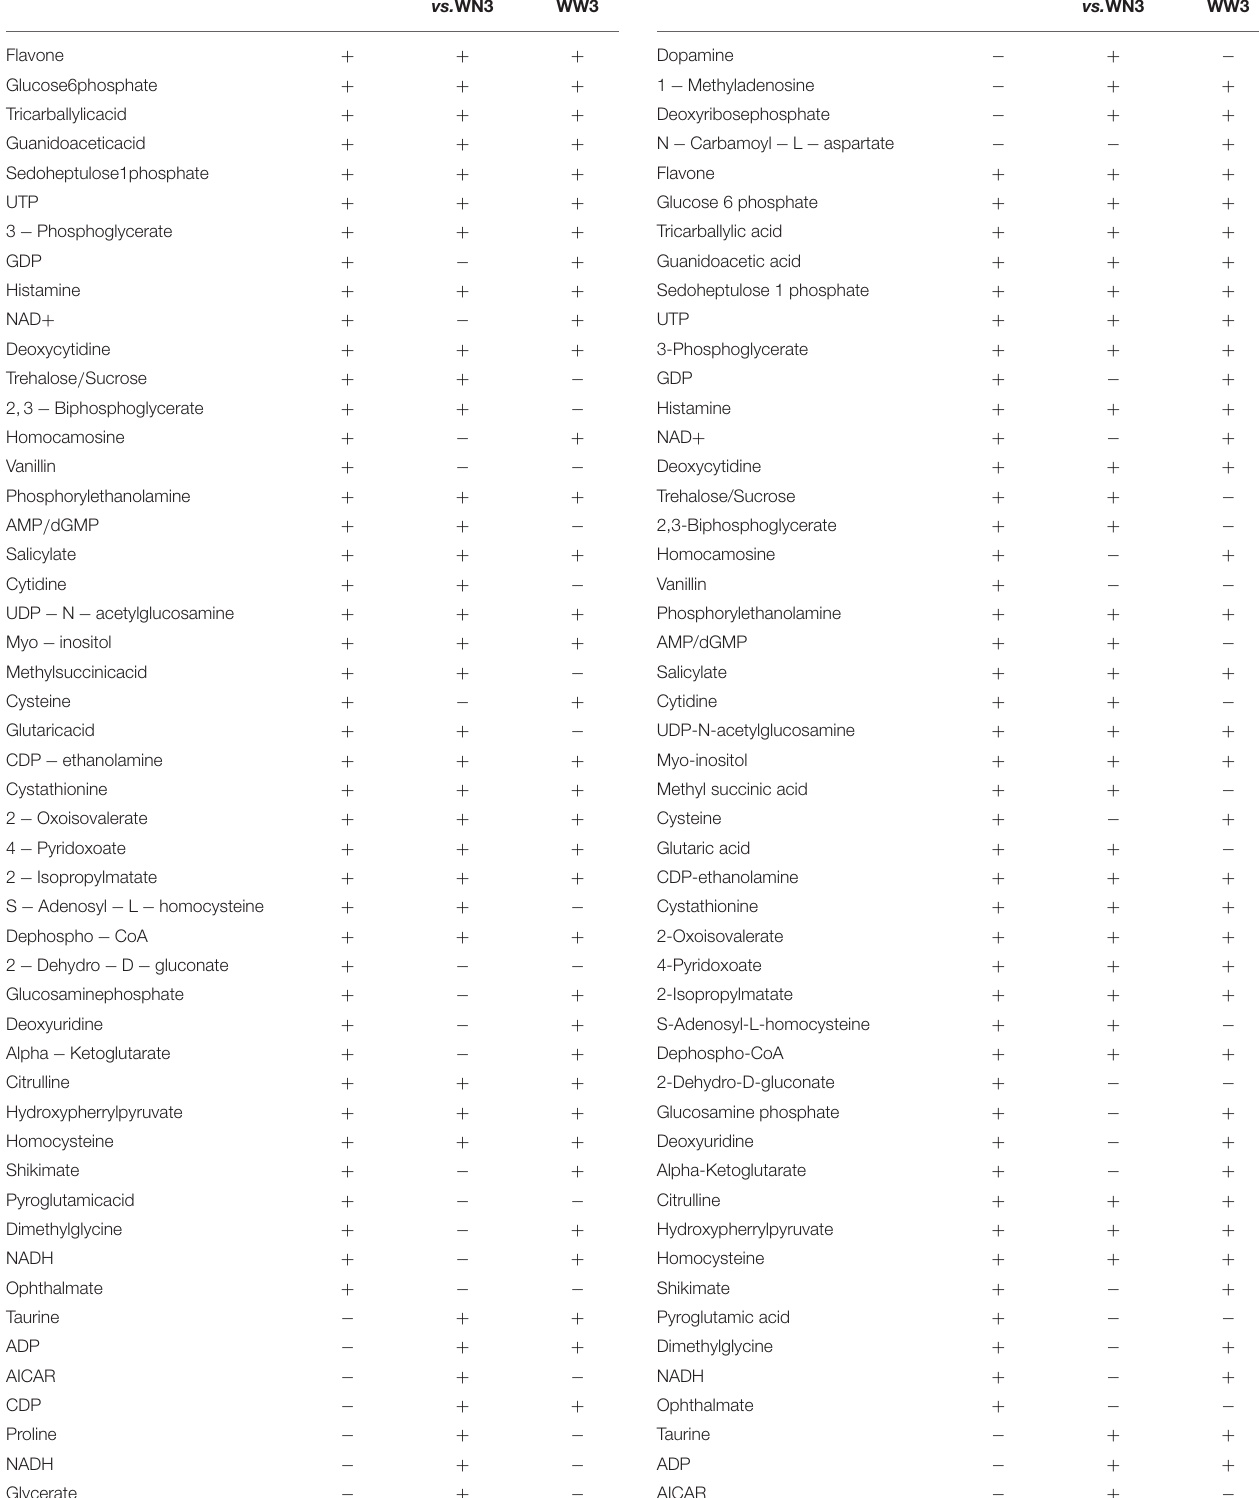
TABLE 1 | Metabolites driving cluster separations based on VIP score a .